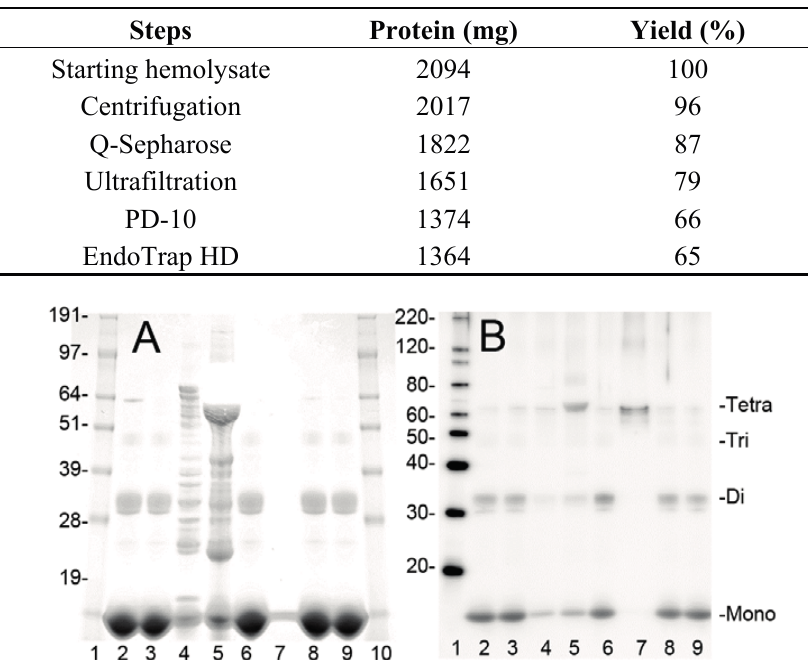
Table 1. Purification of bovine hemoglobin.